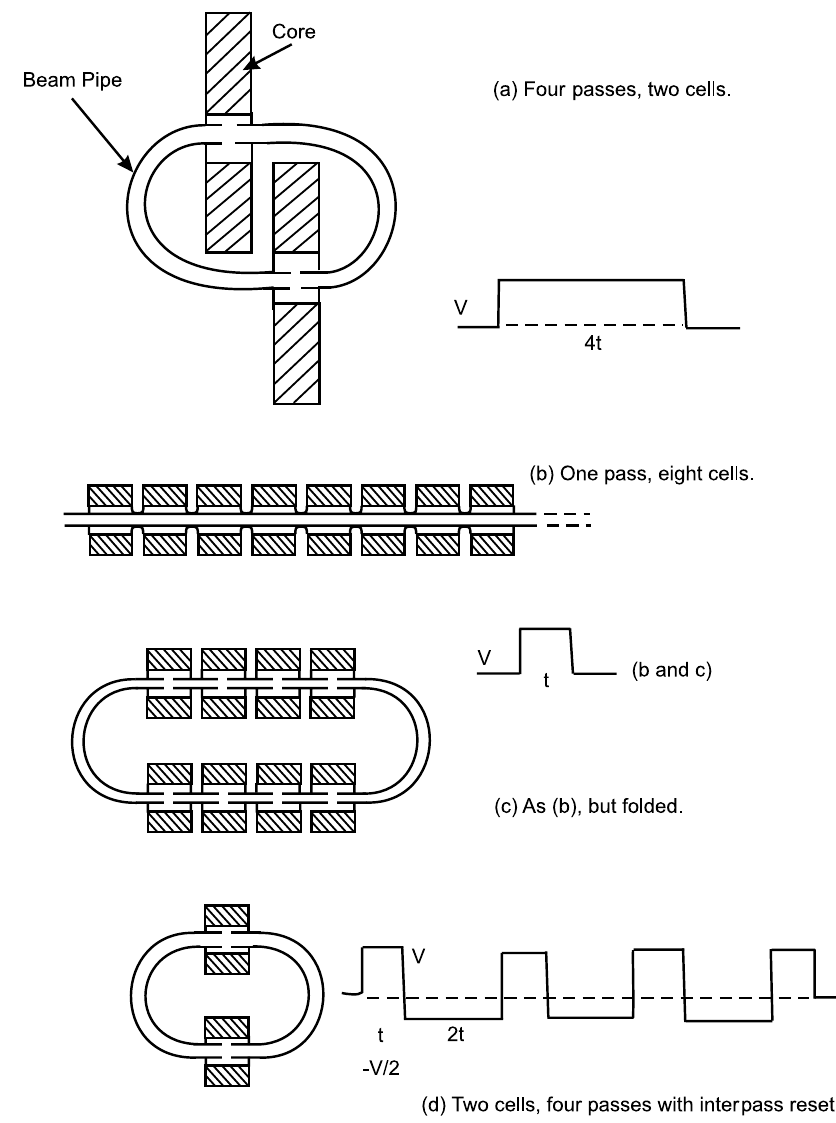
FIG. 8. Schematic comparison of recirculating and linear accelerators.